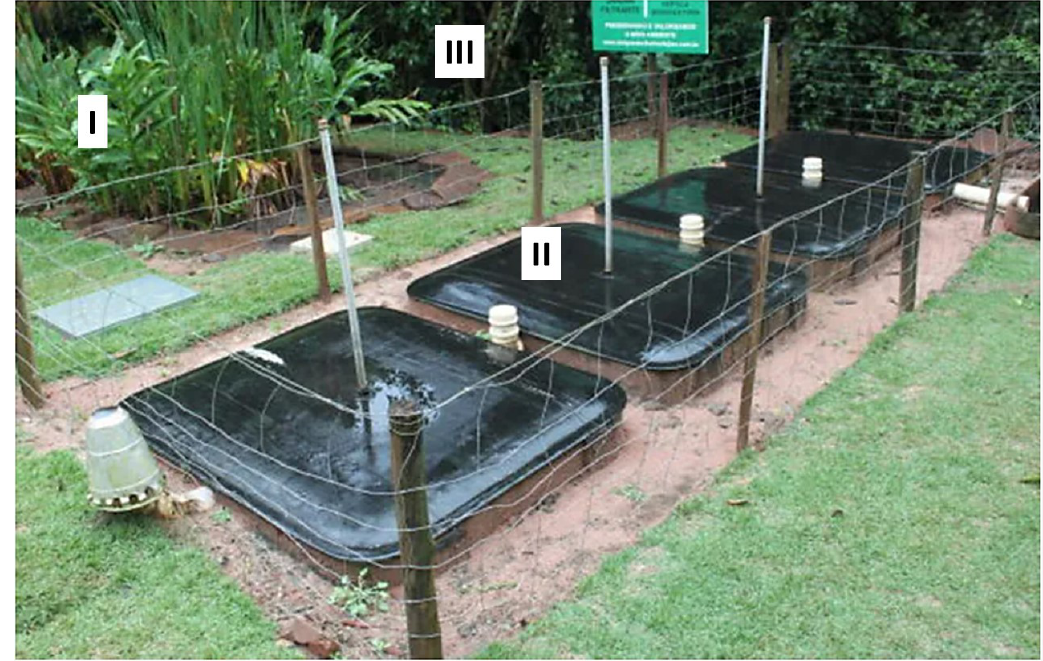
Fig. 6. In (I) Filter Garden; (II) biodigestor septic tank installed and in (III) Ribeirão Feijão watershed margem, adapted from Hernandes (2021),